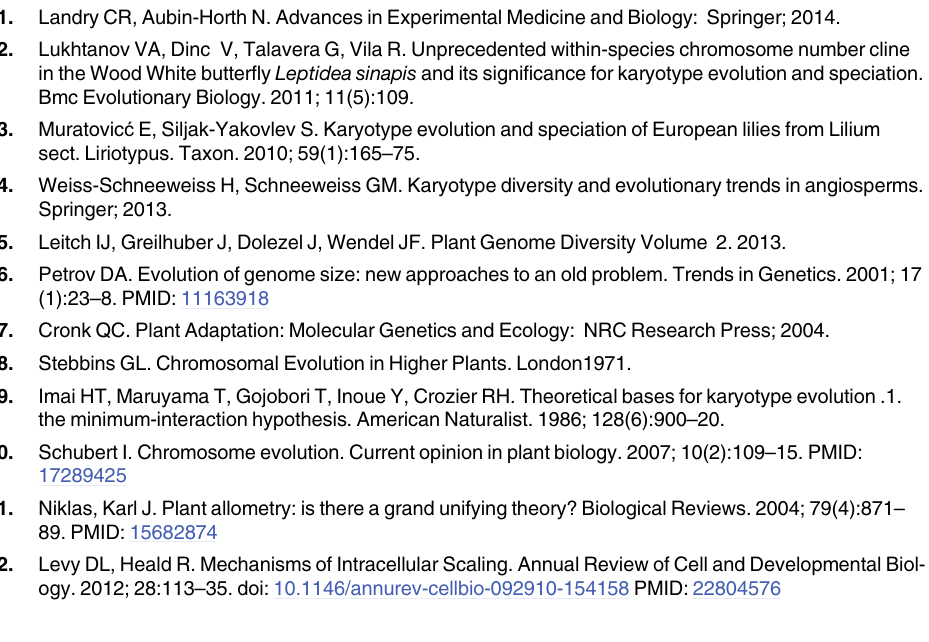
S1 Table. The chromosome traits for the 191 species used in the current study. LF = life form, D = deciduous species, E = evergreen species, TCN = total chromosome number, m- CN = m-chromosome, KAI = karyotype asymmetry index, LcN = long chromosome number, ScN = short chromosome